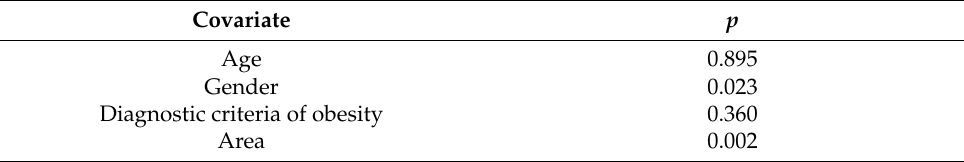
Table 3. Meta-regressions by age, gender, diagnostic criteria of obesity and area.